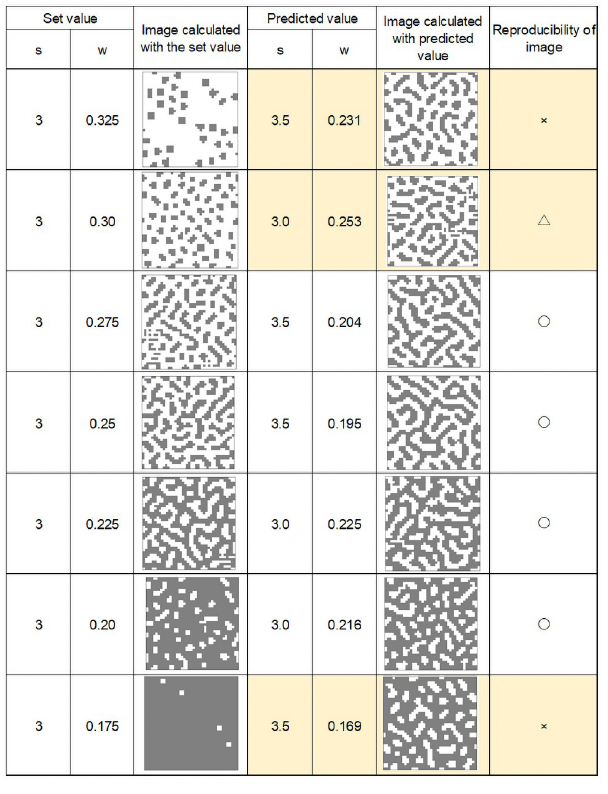
Fig 11. Calculation results